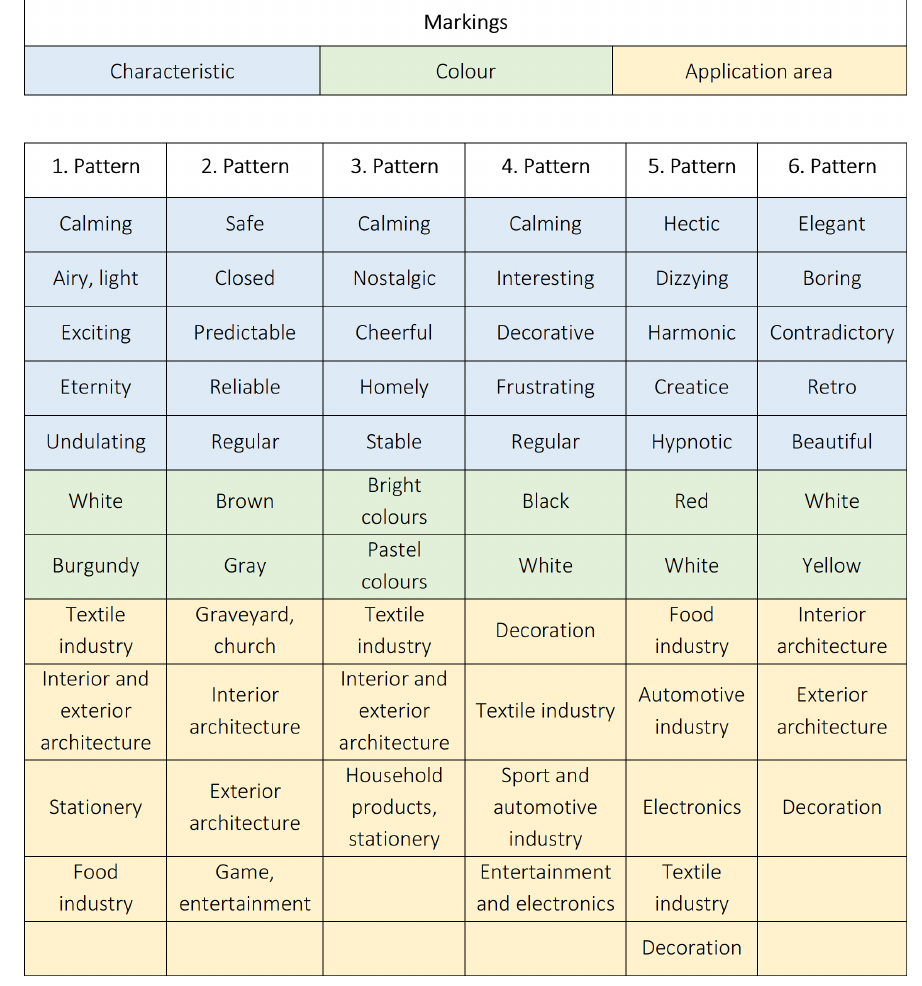
Figure 14. Focus group interview—Significant characteristics, colours, application